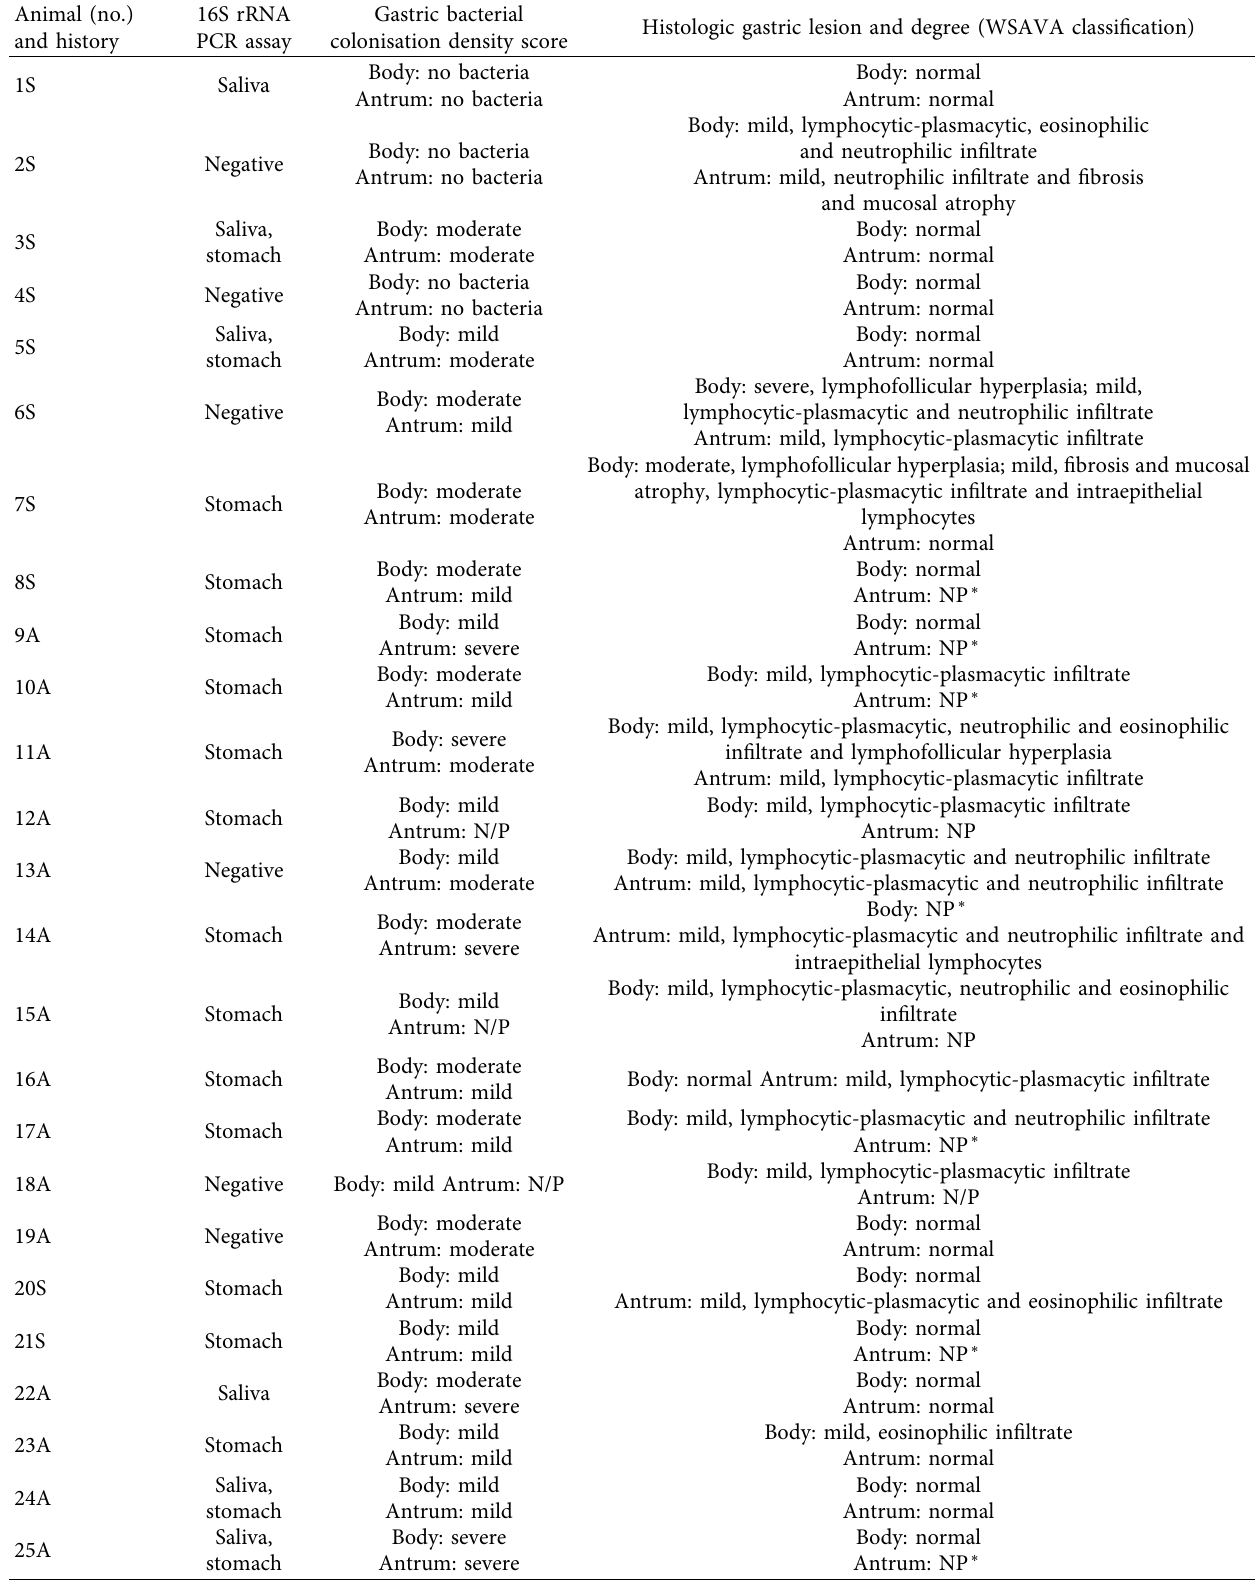
Table 3: Case by case of frequency of the gastric bacterial colonisation density, presence of 16rRNA Helicobacter genus on saliva and stomach, and histologic findings with degrees of WSAVA classification. Animal